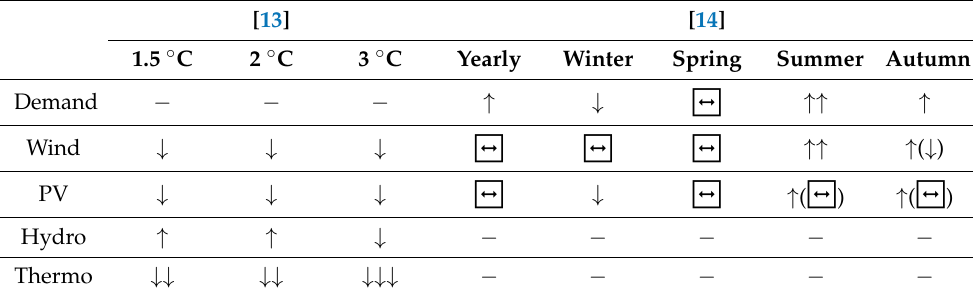
Table 1. Comparison between [13,14] for Italy. Where: one arrow, two arrows or three arrows mean that there is a reduction/increase less or equal to 5%, 10%, 15% respectively. The left–right arrow means an insignificant variation. The symbols inside brackets are used for the RCP 8.5 scenario, when it gives a response different in sign with respect to the RCP 4.5 scenario.